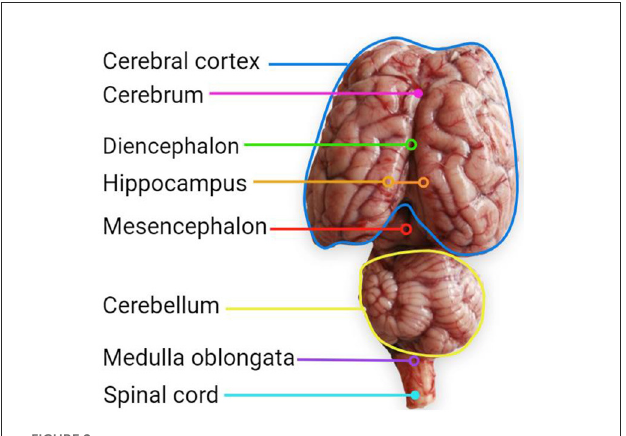
FIGURE2 Brain regions of a 3 months weaned female Dorset lamb (89.3g), with a barley hay-based diet with 5% fishmeal